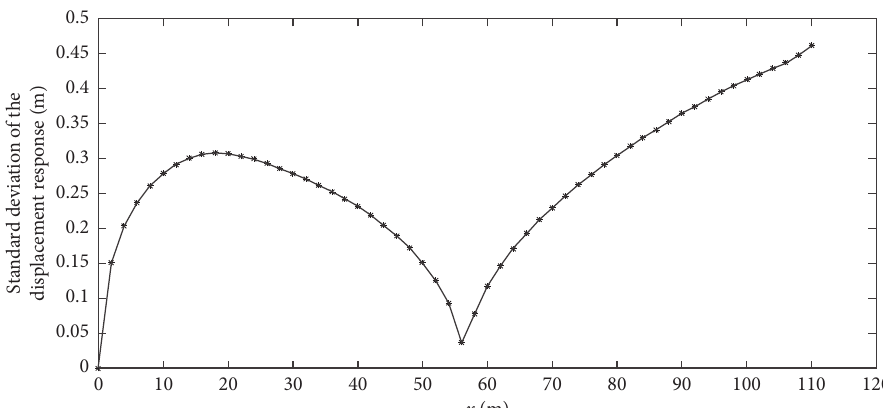
Figure 8: Standard deviation of the displacement response with the subsea BOP ( H